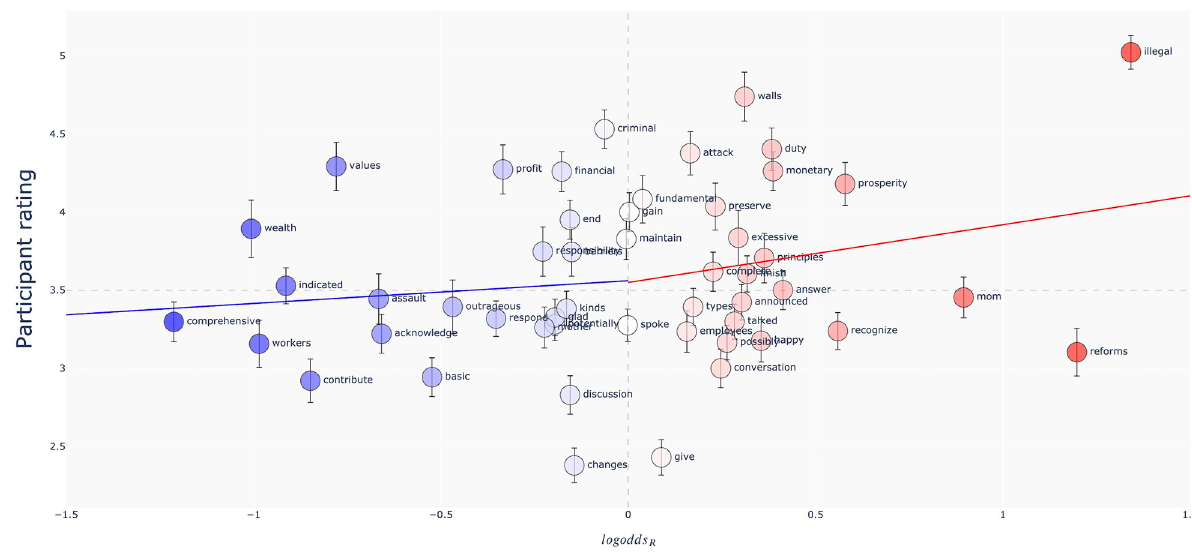
Fig 4. Results of Study 3a. The logodds R of each word against the average rating given to the word. A rating of 6 corresponds to a judgment of “I am almost certain the speaker is a Republican”, while a rating of 1 corresponds to “I am almost certain the speaker is a Democrat.” Words are colored by logodds R . Vertical bars mark one standard error around the mean of the ratings. The blue and red lines show the estimated linear trends using only the Democratic items and Republican items, respectively.